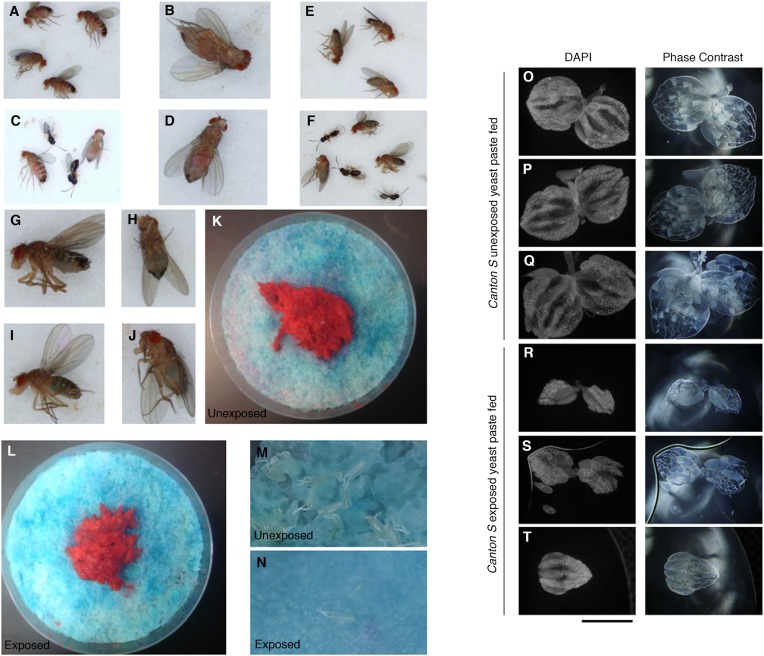
Flies continue to eat high protein diet following wasp exposure but still depress oviposition.Additional evidence demonstrating that exposed flies eat rich nutrient food. (A) Unexposed flies after 24-hour period. (B) Ventral view of unexposed fly. (C) Exposed flies with wasps after 24-hour period. (D) Ventral view of exposed fly. (E) Unexposed flies after a 24-hour period fed only blue food have blue abdomens. (F) Exposed flies with wasps after a 24-hour period fed only blue food have blue abdomens. Percent of male and female flies with red food in abdomen. (G) Lateral view of unexposed fly. (H) Ventral view of unexposed fly. (I) Lateral view of exposed fly. (J) Ventral view of exposed fly. (K) Food plate from unexposed flies following 24-hour period. (L) Food plate from exposed flies following 24-hour period. (M) Zoom-in of food plate from unexposed flies showing many eggs. (N) Zoom-in of food plate from exposed flies showing few eggs. (O to Q) Unexposed Canton S ovaries from individuals fed yeast paste for 24 hours. (R to T) Exposed Canton S ovaries from individuals fed yeast paste for 24 hours.